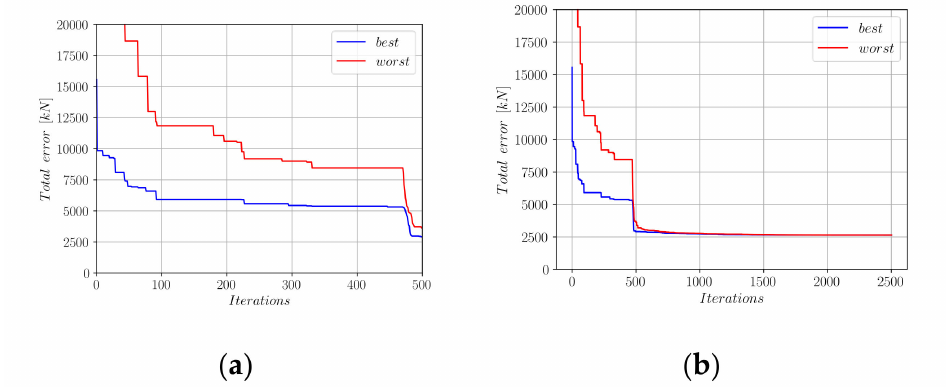
Figure 9. Decrease in the total error throughout the harmony search iterations (Equation (20)). ( a ) First 500 HS iterations; ( b ) First 2500 HS